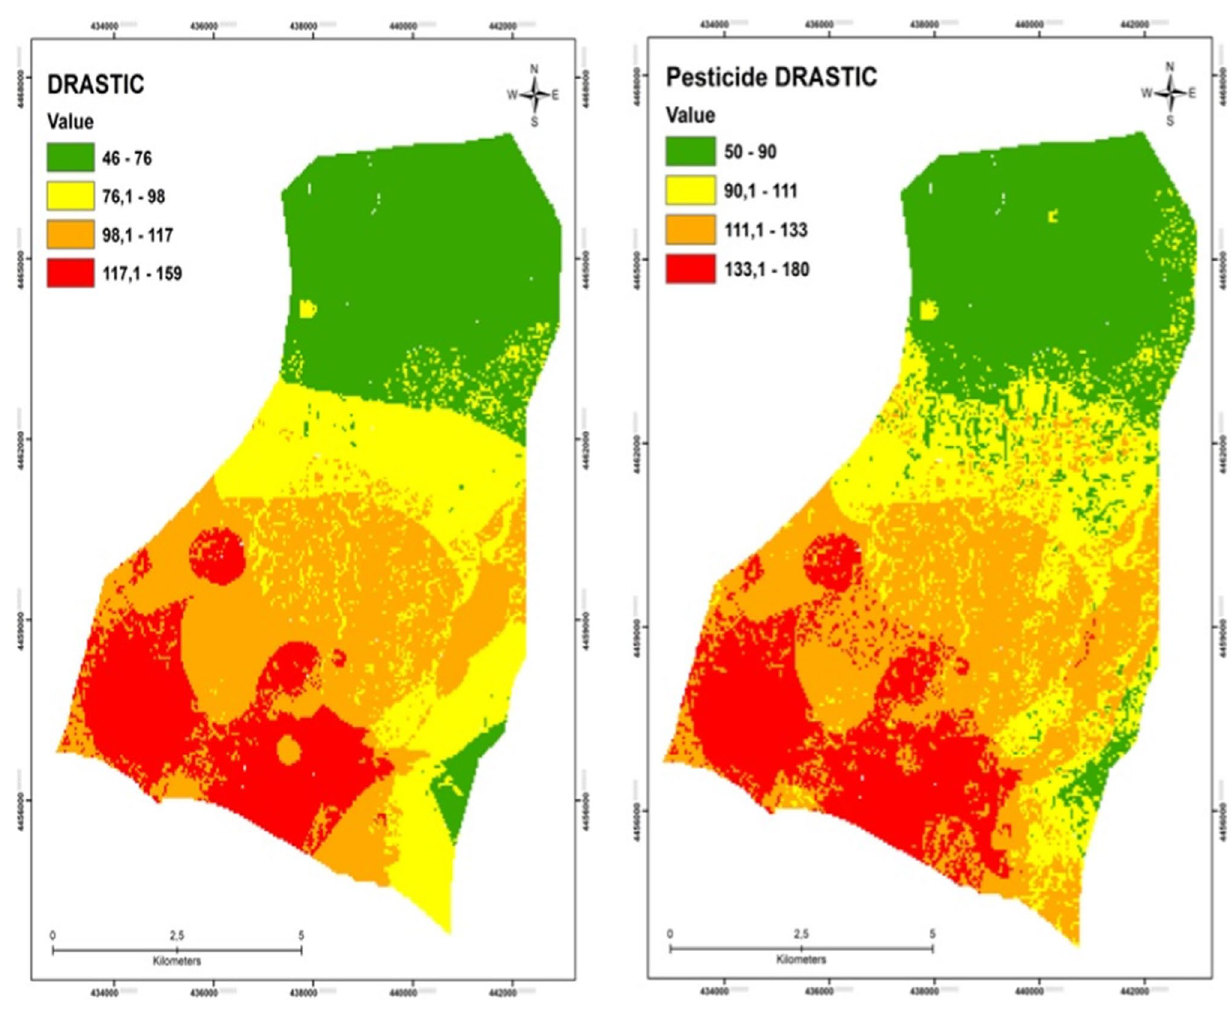
Fig. 5 a DRASTIC vulnerability map (left) and b Pesticide DRASTIC vulnerability map